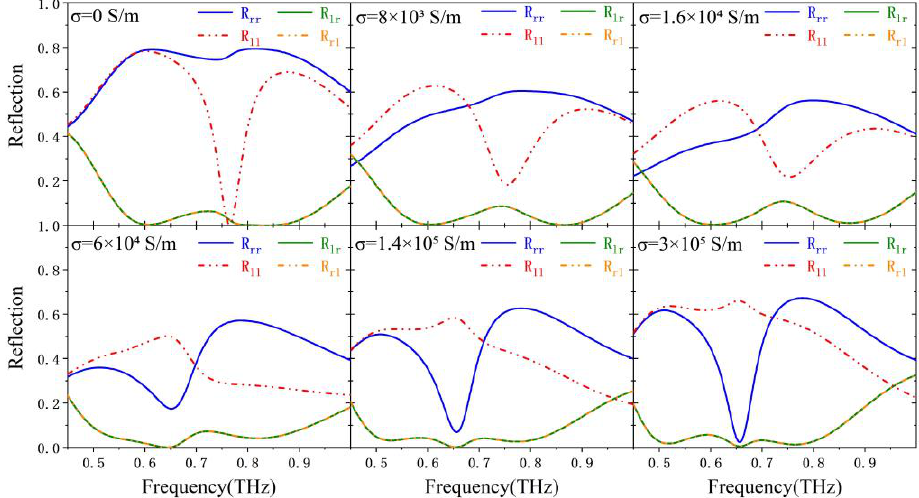
Figure 3. Reflection spectra of ASRR_1 with different conductivities of